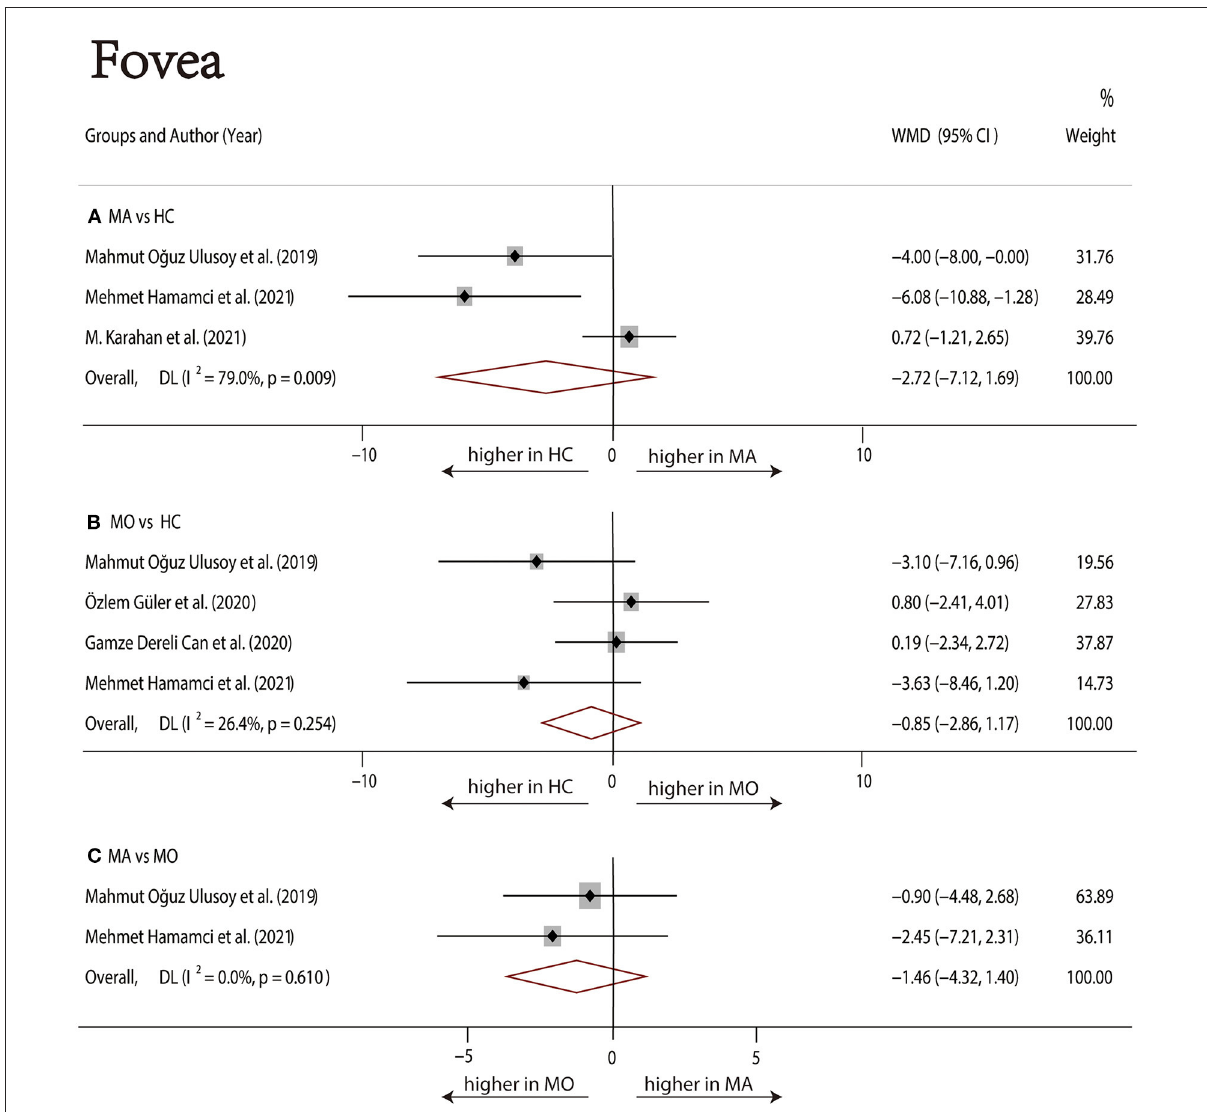
FIGURE4 Forest plot of WMD of the foveal SCP VD. (A) Foveal VD comparison of MA and HC; (B) Foveal VD comparison of MO and HC; (C) Foveal VD comparison of MA and